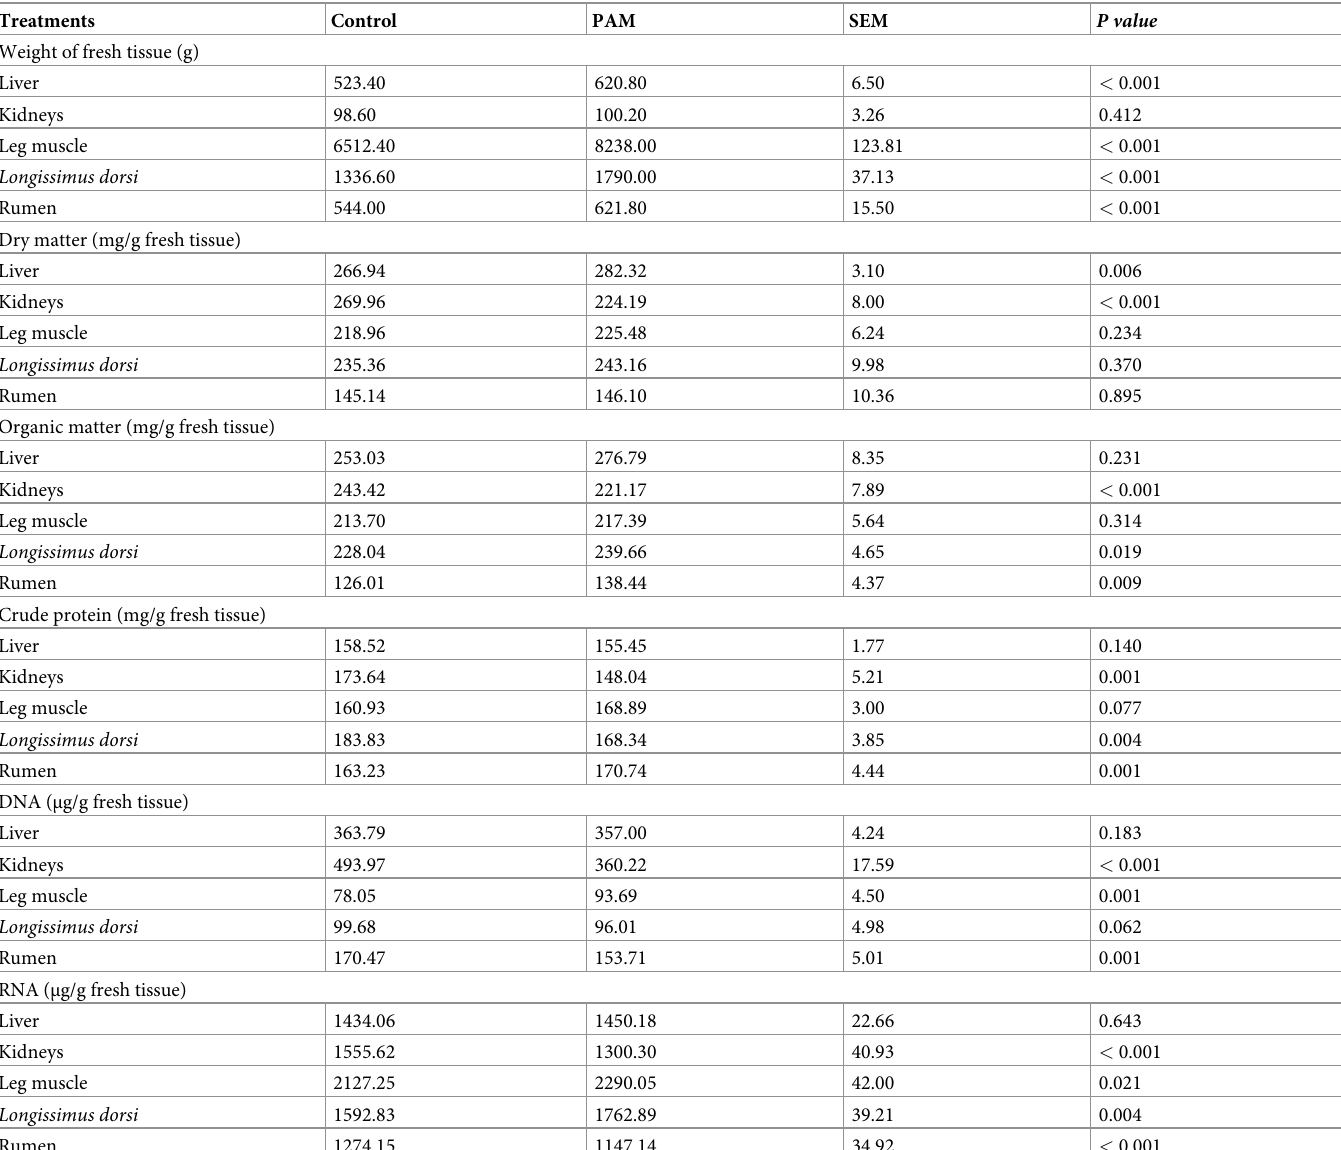
Table 6. Effects of PAM on the fresh weight and the contents of DM, OM, CP, DNA, and RNA in the internal organs and muscles of